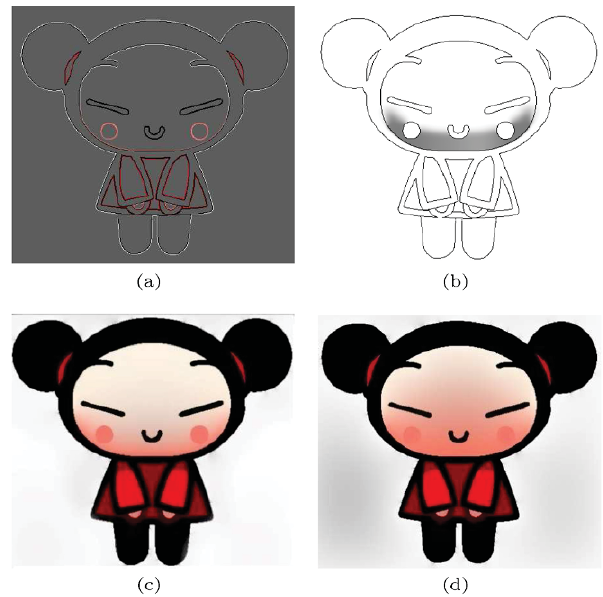
Fig. 7 Girl image generated by the DCC model, using strength coefficients to control diffusion strength within a region. (a) Color layer. (b) Strength coefficient layer, with small strength coefficients in the regions around the two red dots. (c) Image generated by the DCC model with the color layer in (a) and the coefficient layer in (b); diffusion of the red dots is effectively hindered in the face region. (d) Image produced by the Poisson model with the color sources defined using the color layer in (a); too much red color spreads into the face